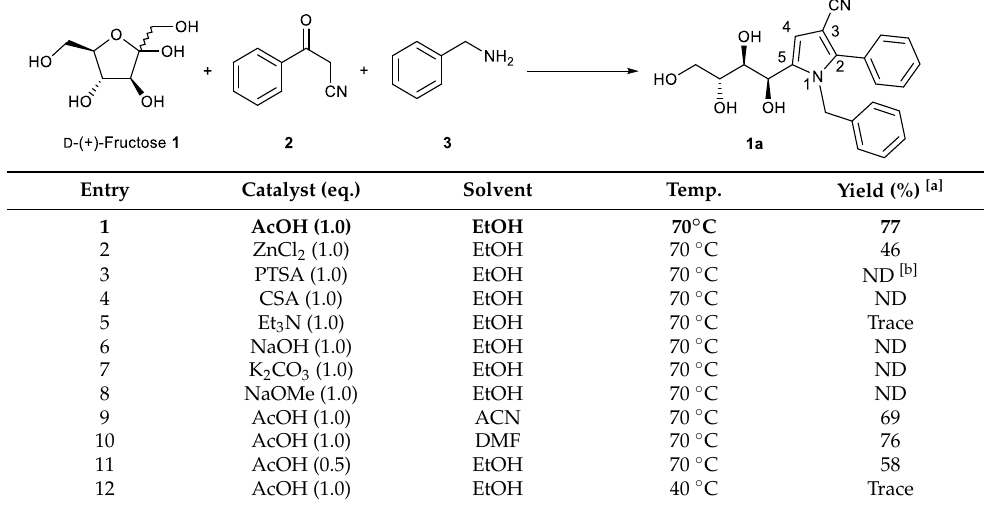
Table 2. Substrate scope of the AcOH-catalyzed three-component reaction between ketoses 1 , and 4 , primary amines 3 and 5 – 12 , and oxoacetonitriles 2 and 13 for the selective synthesis of 3-cyanopyrroles 1a – k and 4a – c . [a].